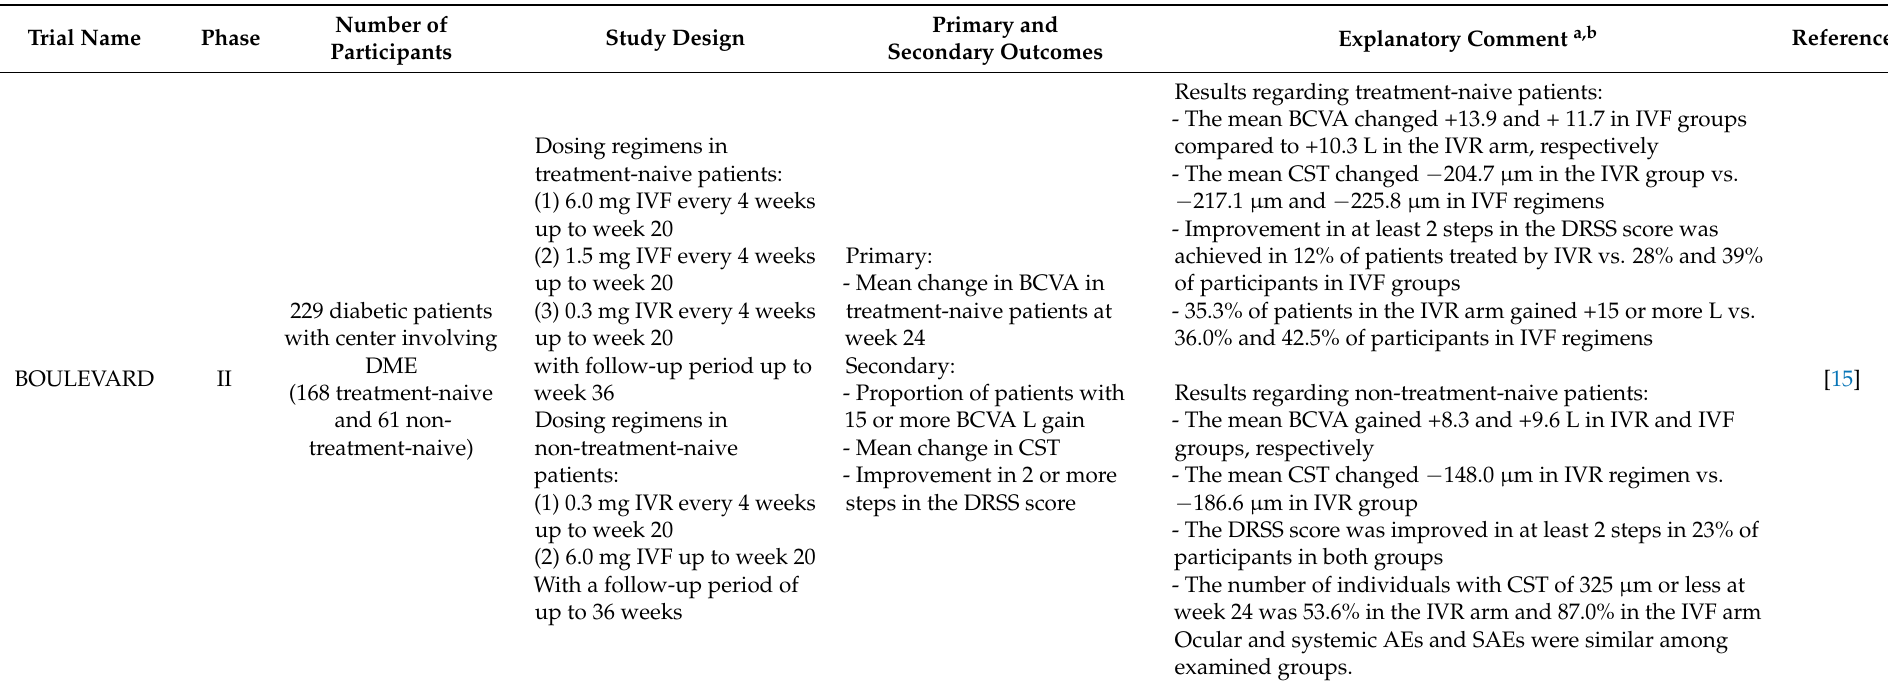
Table 5. Summary of clinical trials assessing the use of faricimab in the treatment of